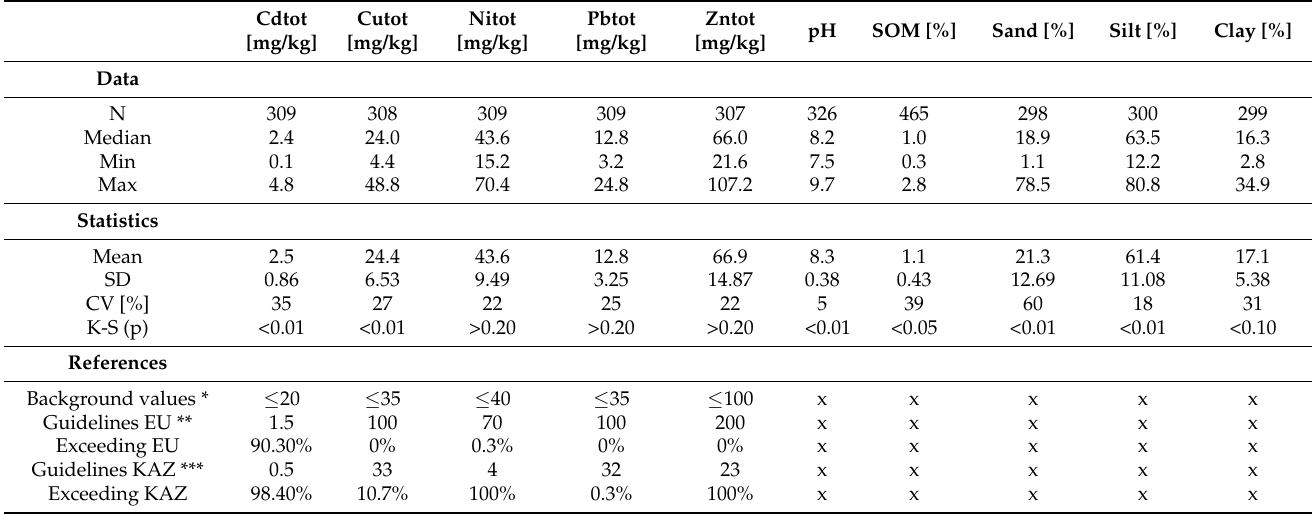
Table 1. The main characteristics of studied soils; background levels and regulatory standards for Kazakhstan and EU